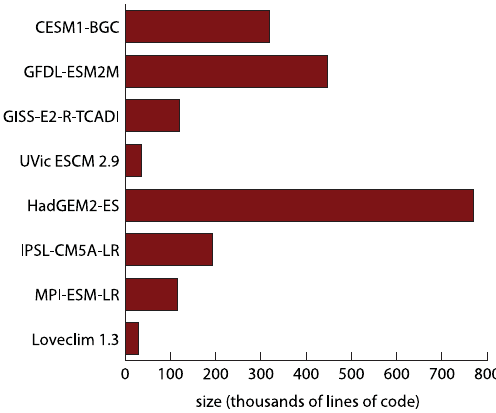
Figure 9. Line count of the source code of each model, exclud- ing comments and blank lines. Generated using David A. Wheeler’s